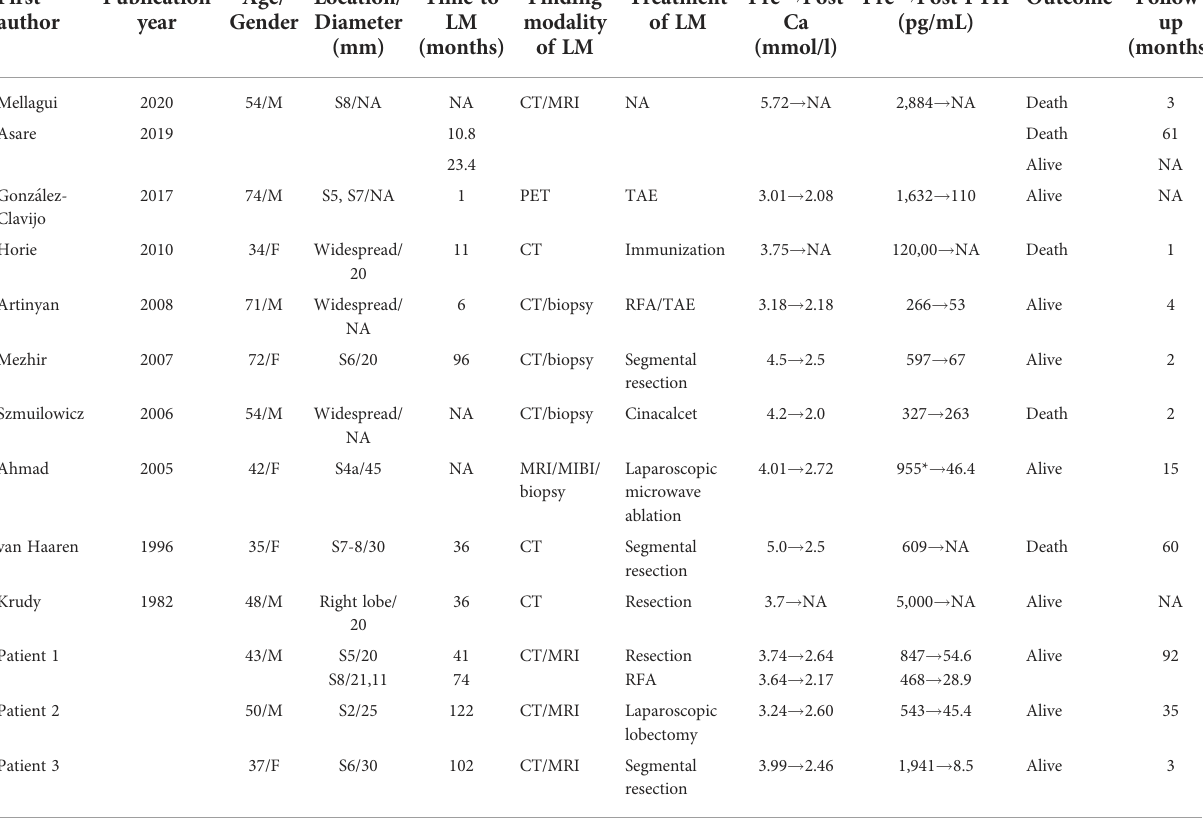
TABLE 2 Literature review and our cases of liver metastases of parathyroid